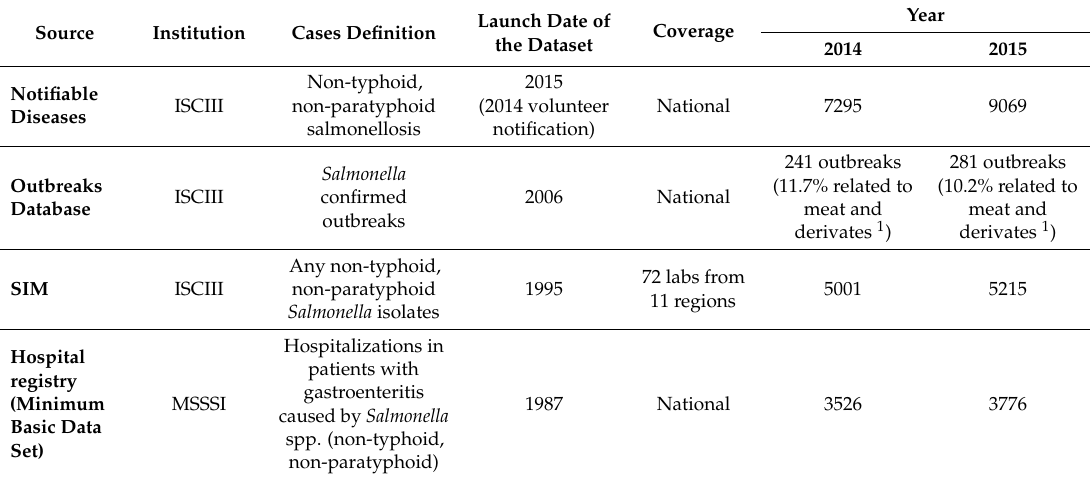
Table 5. Summary of results from the different sources, years 2014 and 2015.